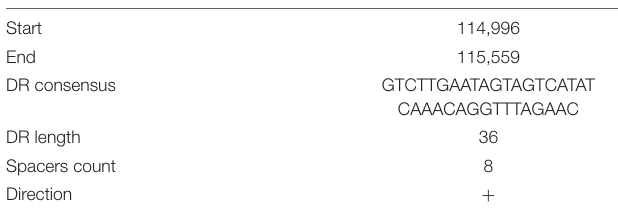
TABLE 4 | Analysis of CRISPR II system direct